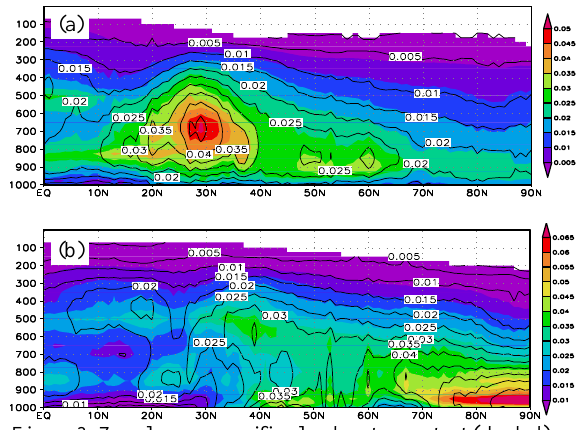
Figure 3. Zonal mean specific cloud water content (shaded) and its polynomial fitting (contour) in Jan (a) and July (b) (kg kg -1 )